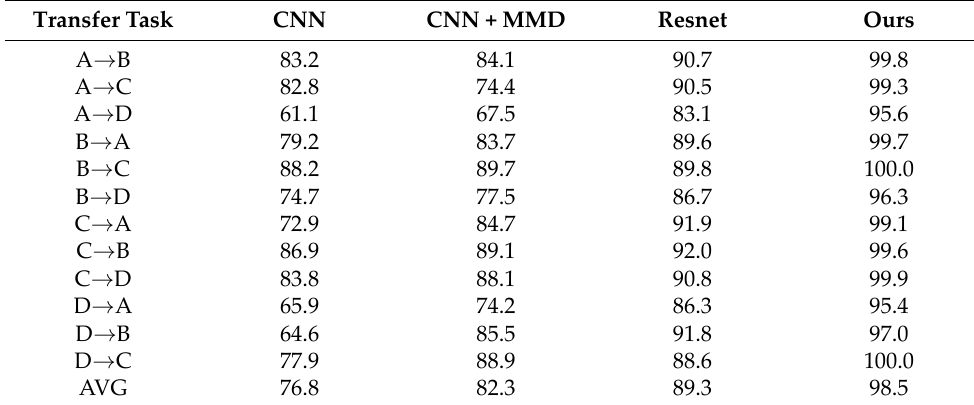
Table 4. Diagnosis accuracy rate of 12 transfer tasks